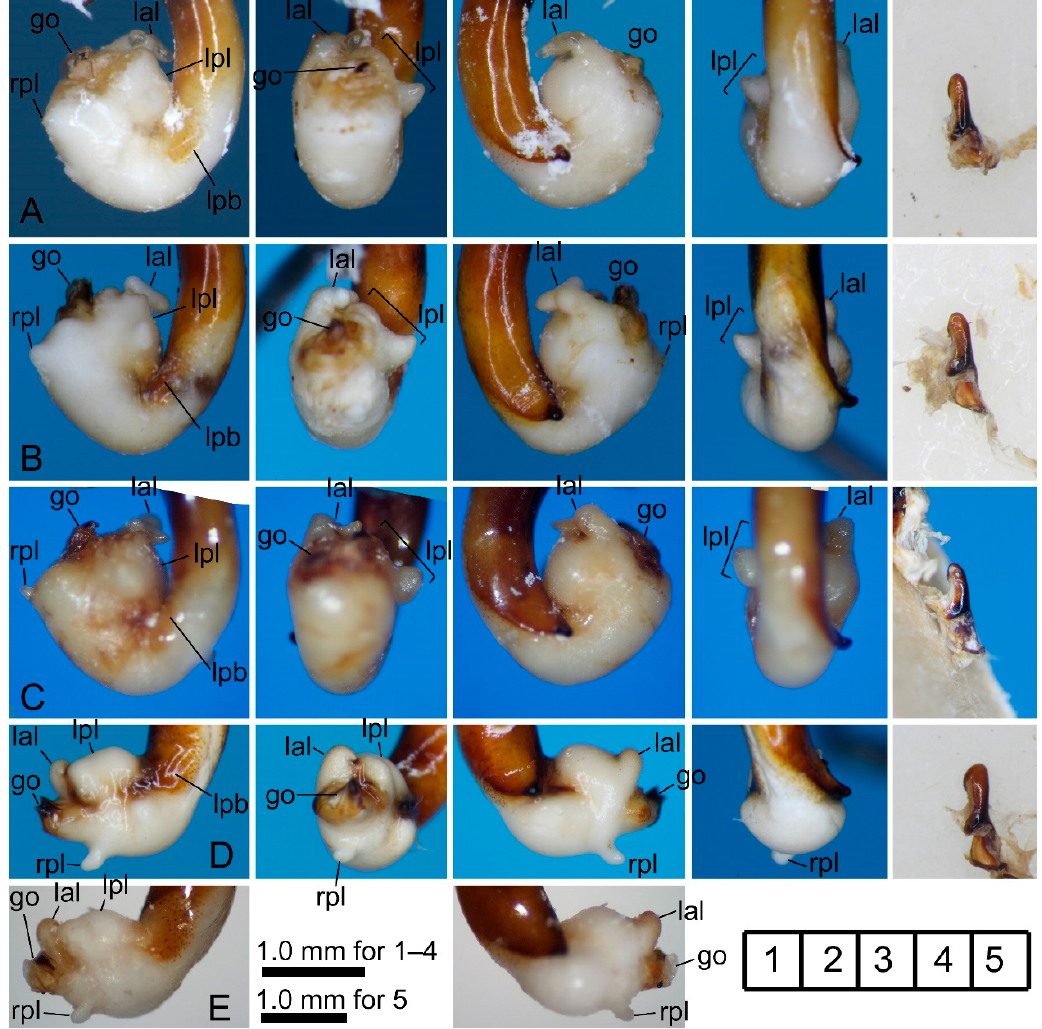
Figure 3. Left lateral ( 1 ), ventral ( 2 ), right lateral ( 3 ), and dorsal ( 4 ) views of aedeagus (part) with the everted endophallus and left lateral view ( 5 ) of right paramere of the macrogenys species group; ( A – C ) P. chokaisanus males from Sakunami ( A ), Kamihôzawa ( B ), and holotype male from “Yashima” ( C ), ( D , E ) P. kurikomasanus male from Yuhama Pass ( D ) and holotype male from “Mts Kurikomasan” ( E ). go: gonopore, lal: left apical lobe, lpl: left preapical lobe, rpl: right preapical lobe. Numbers in the grid on the right bottom indicate subfigure placement.